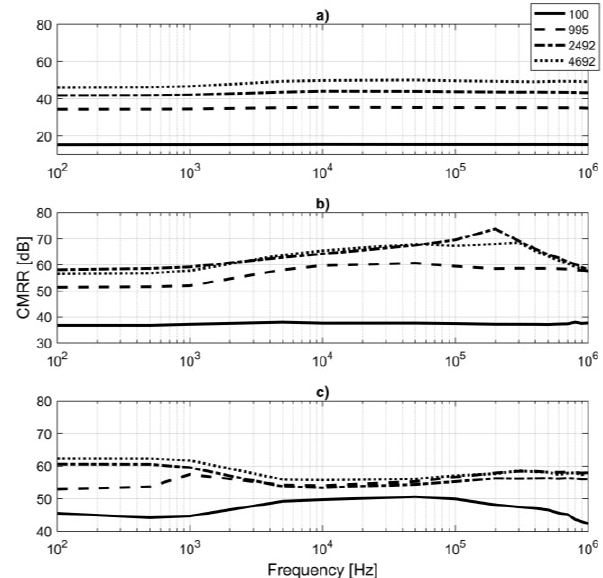
Fig.27: Measured common mode rejection ratio (CMRR). a) QUAD b) DIF_C c) DIF_M